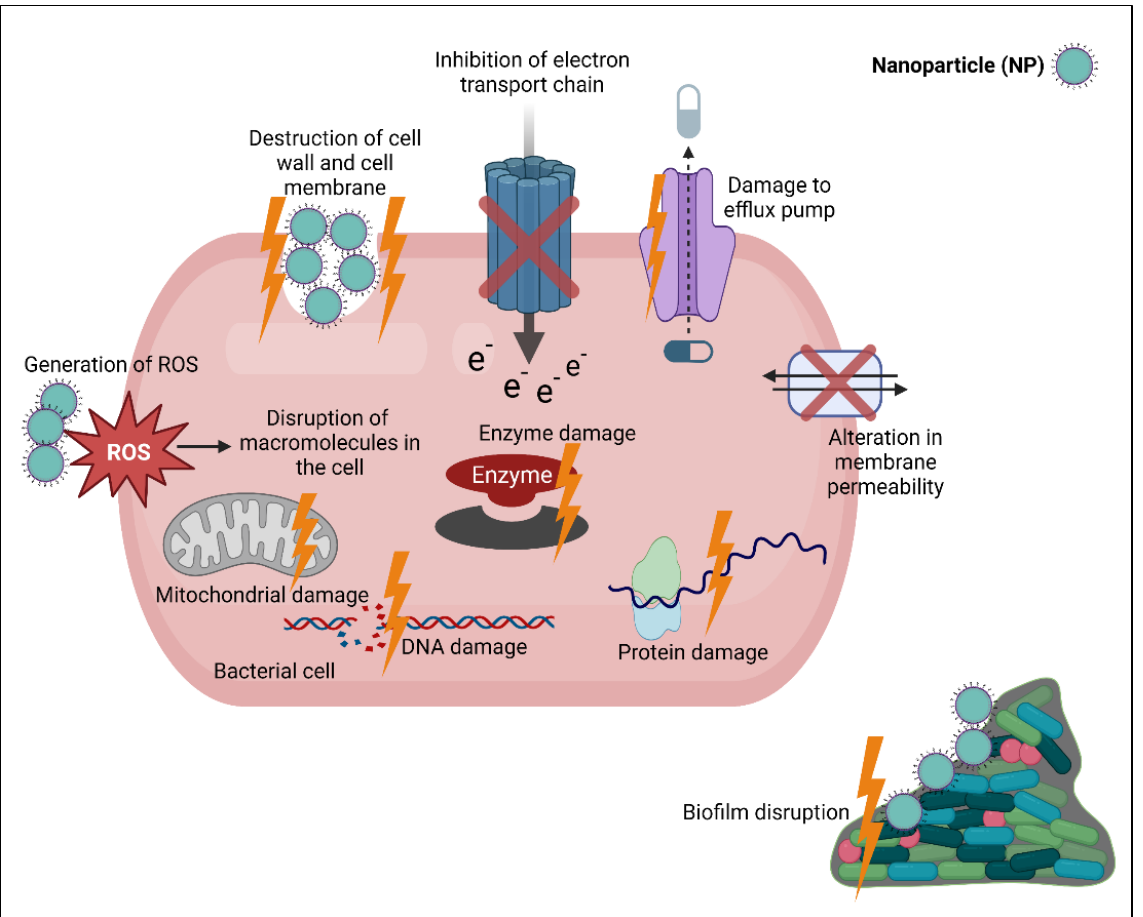
Figure 4. Mechanisms of action of NPs. They act through destruction of bacterial cell wall and cell membrane, overproduction of reactive oxygen species (ROS) that produce oxidative stress and damage vital intracellular macromolecules, as well as inflict protein damage, enzyme damage, mitochondrial damage, DNA damage, alteration in membrane permeability, prevent extrusion of drug through damage of efflux pump, inhibition of electron transport chain and prevent and disrupt biofilm.